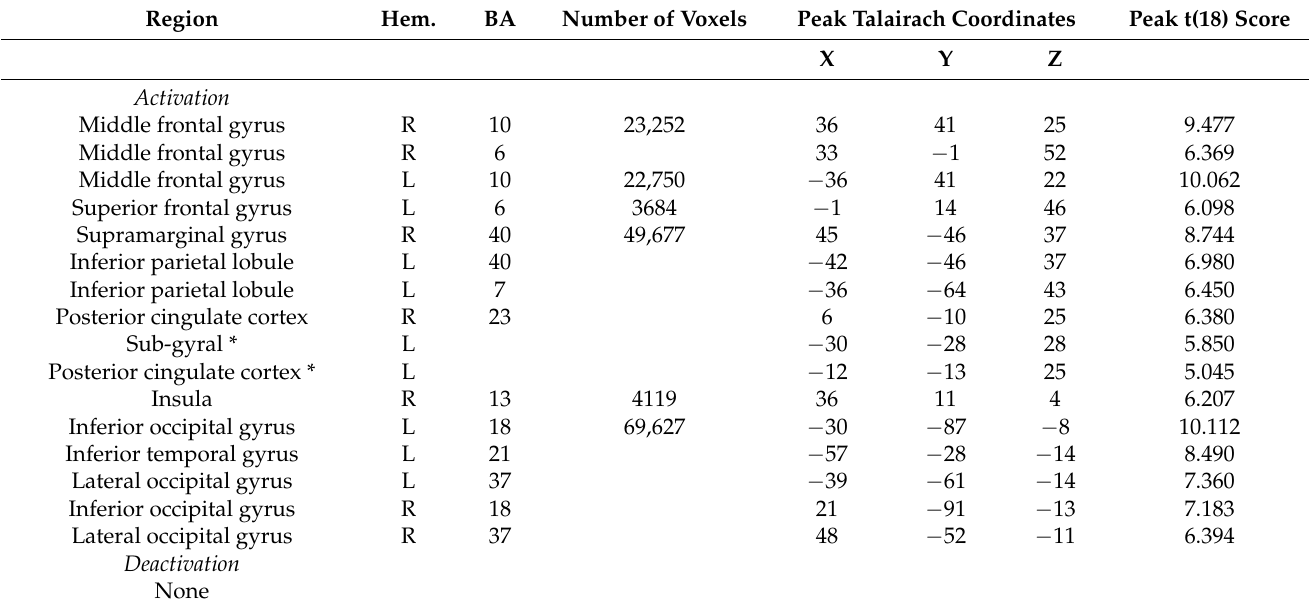
Figure 1. Brain activations associated with approximate calculation strategy (AC-A) or sense of magnitude (SOM-B). ( A ) AC elicited activation in the frontal cortex; in the posterior parietal cortex, including the intraparietal sulcus, and the fusiform gyrus. Significant deactivations were found in the right middle temporal gyrus and in the left medial frontal gyrus. ( B ) SOM invokes regions in the frontal cortex; in the posterior parietal cortex in the right and left posterior cingulate cortex; in the occipital lobule; and in the left inferior temporal gyrus. Table 2. Brain areas that showed significant activation in sense of magnitude